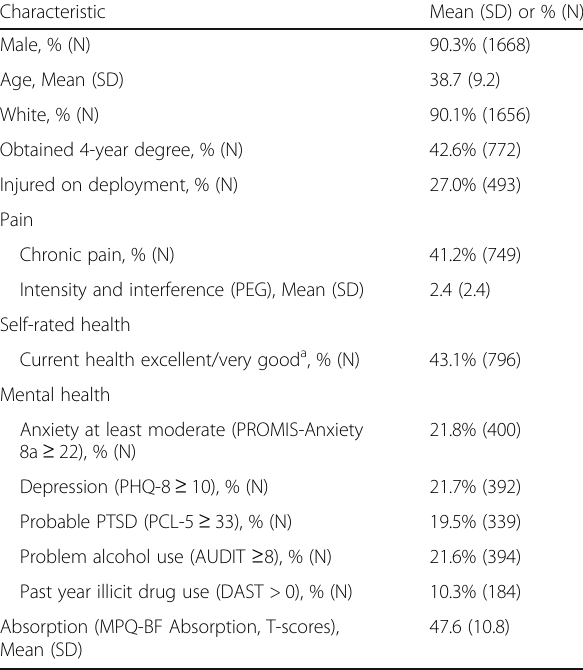
Table 1 Characteristics of Minnesota National Guard